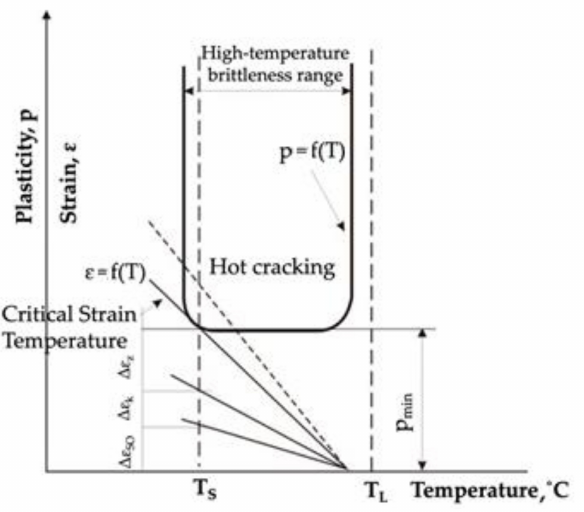
Figure 4. Dependence of alloy ductility within the HTBR and the strain rate